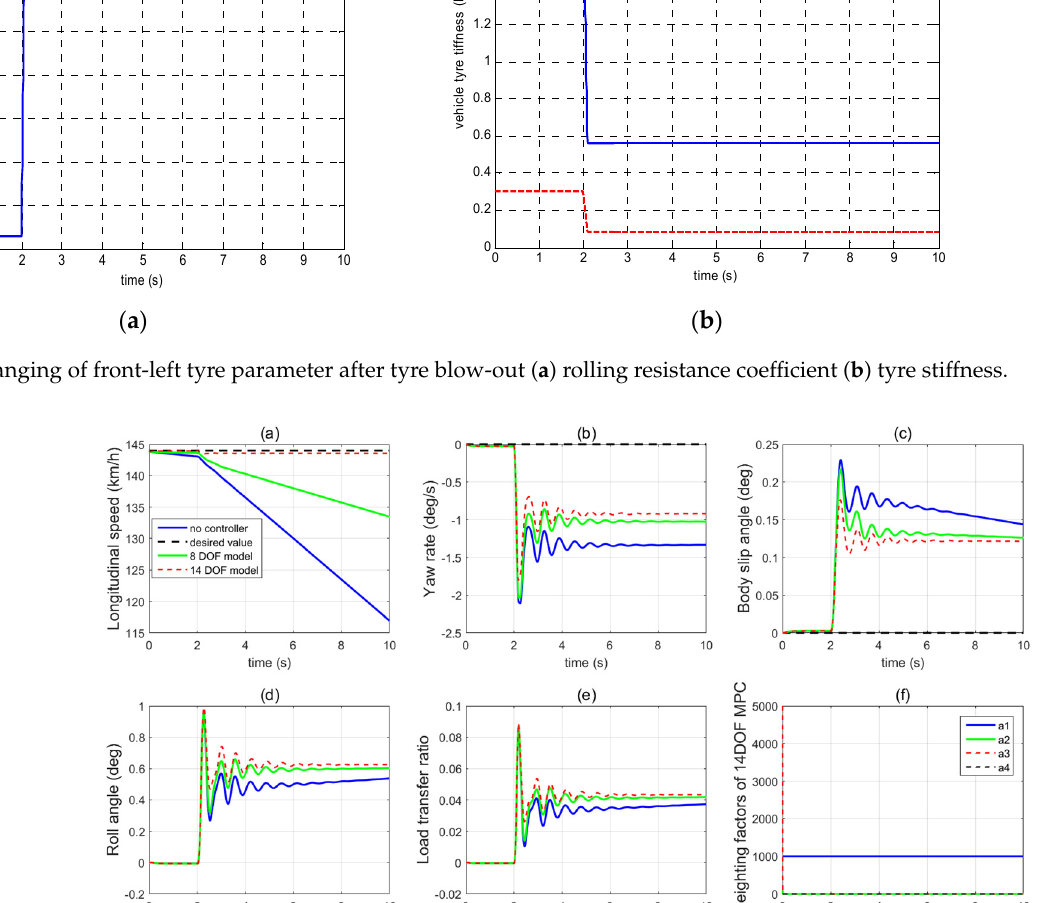
Figure 11. Vehicle motor control inputs in the first set of simulations ( a ) front left wheel, ( b ) front right wheel, ( c ) rear left wheel, ( d ) rear right wheel. Figure 12 shows the sensitivity analysis of the proposed 14 DOF MPC under different tyre–road friction coefficient conditions and different rolling resistance coefficients after a tyre blow-out. The proposed 14 DOF MPC controller shows a quite robust control perfor- mance.